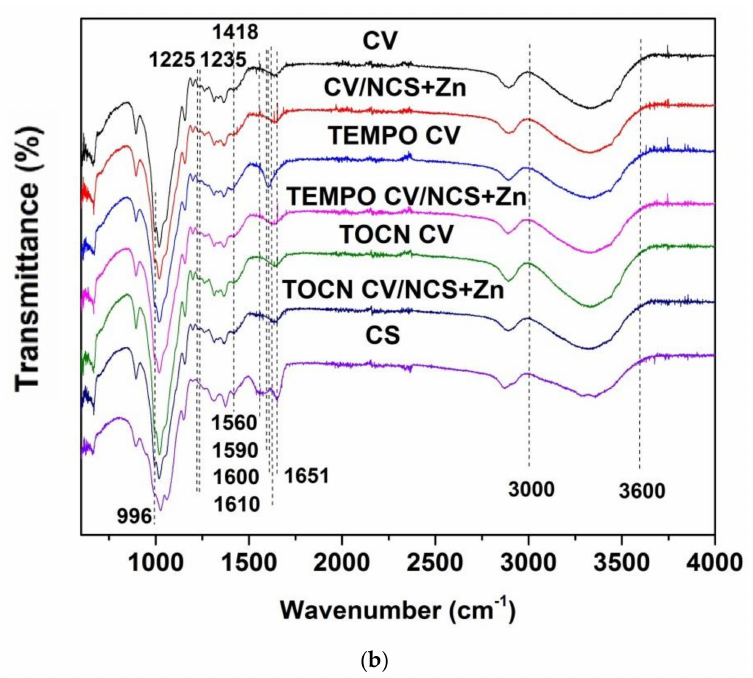
Figure 1. FTIR spectra of ( a ) NCS and ( b ) NCS + Zn functionalized viscose fabrics, modified from